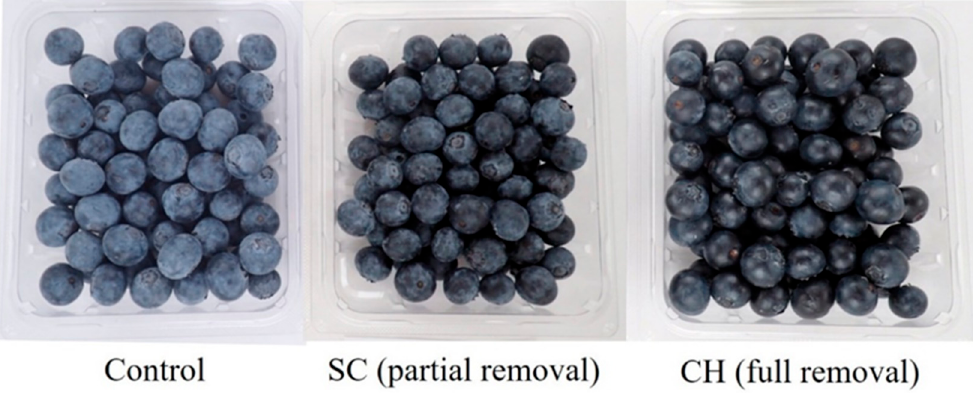
Figure 1. Differential removal of waxy bloom due to coating application. SC being an example of partial and CH of full removal of the waxy bloom.